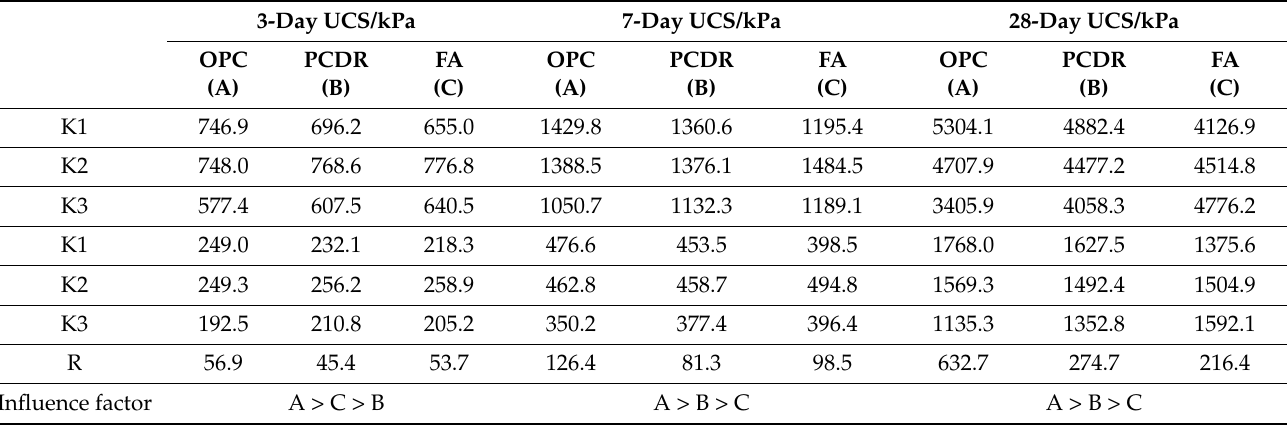
Table 7. Orthogonal extreme difference